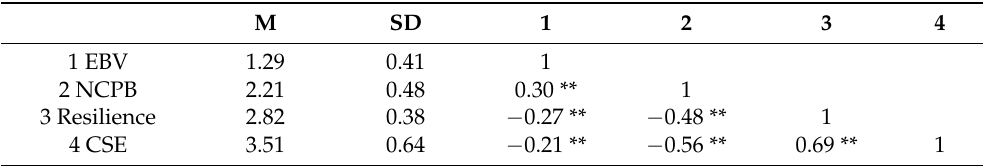
Table 1. Descriptive statistics and correlations for study variables (N = 972). M